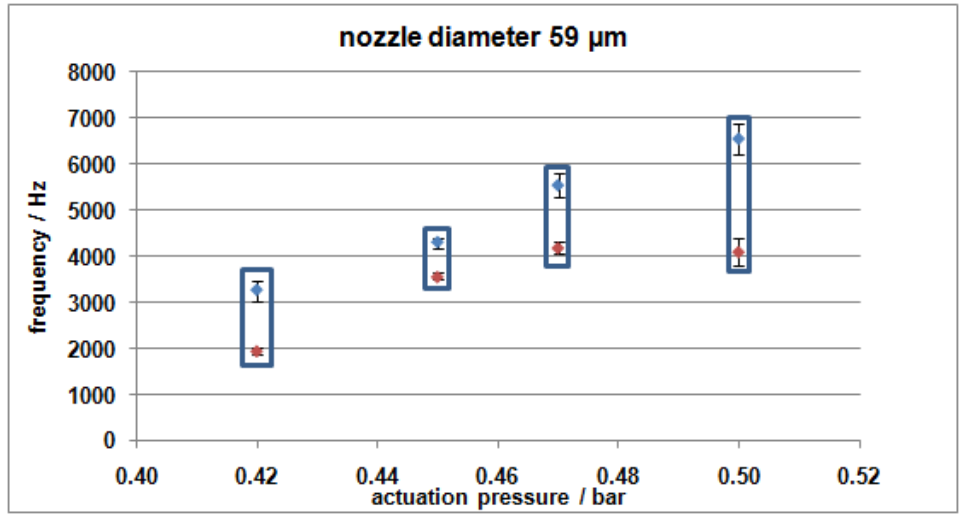
Figure 11. Droplet generation frequency as a function of the rinse pressure (two channel setup) in combination with fixed actuation pressures. The blue marks (max. adjustable frequency for given actuation pressure) belongs to the highest rinse pressure for proper operation, and the red marks (min. adjustable frequency for given actuation pressure) belongs to the lowest rinse pressure for proper operation (nozzle diameter D = 59 μ